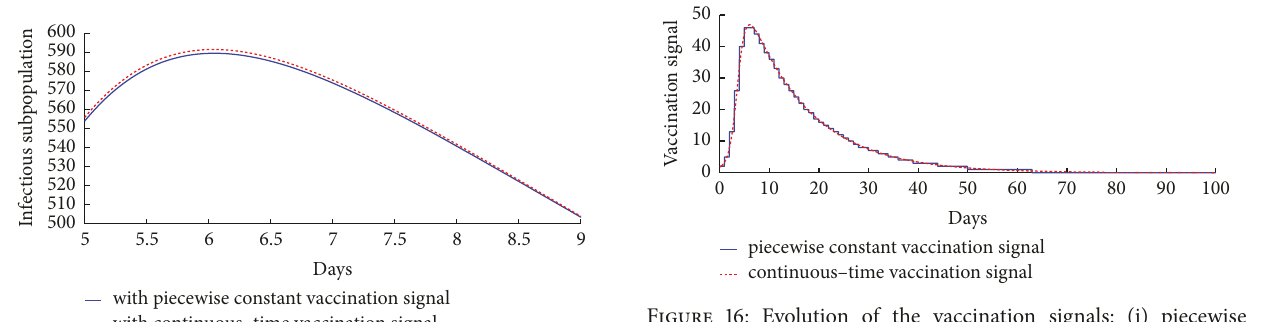
Figure 16: Evolution of the vaccination signals: (i) piecewise